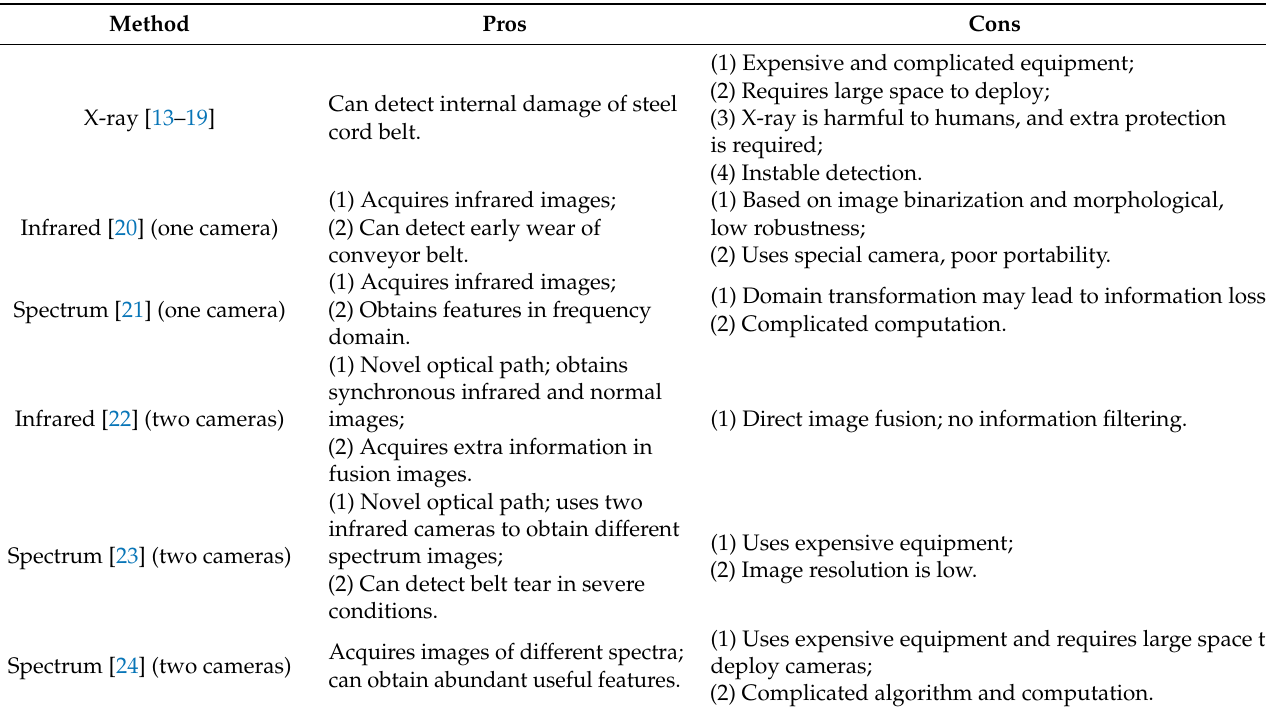
Table 2. Comparison of X-ray/spectrum